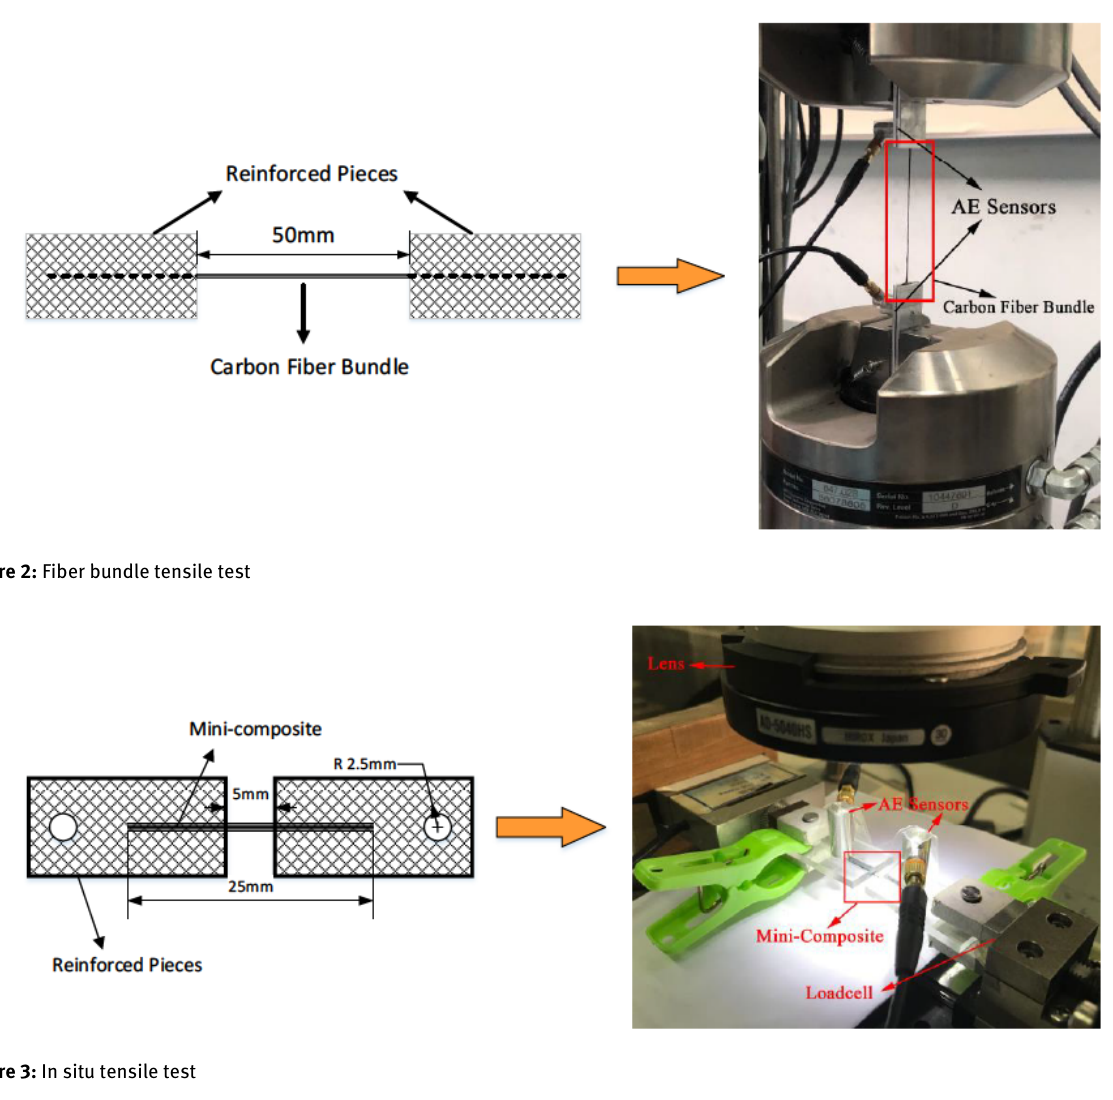
Figure 3: In situ tensile